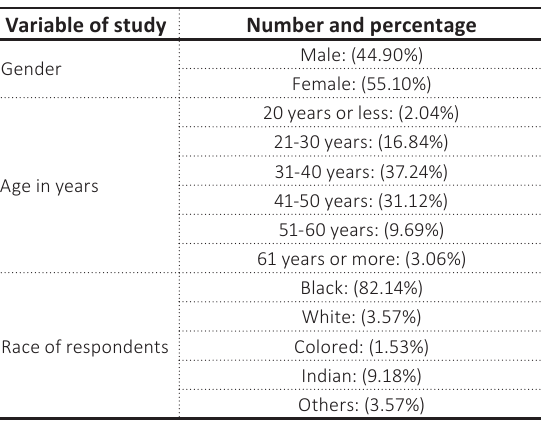
Table 1. Summary of gender, age, and